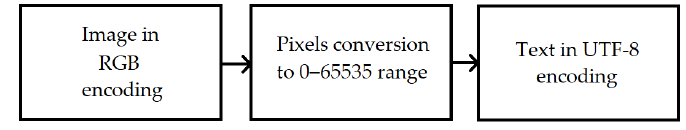
Figure 3. Image to text conversion